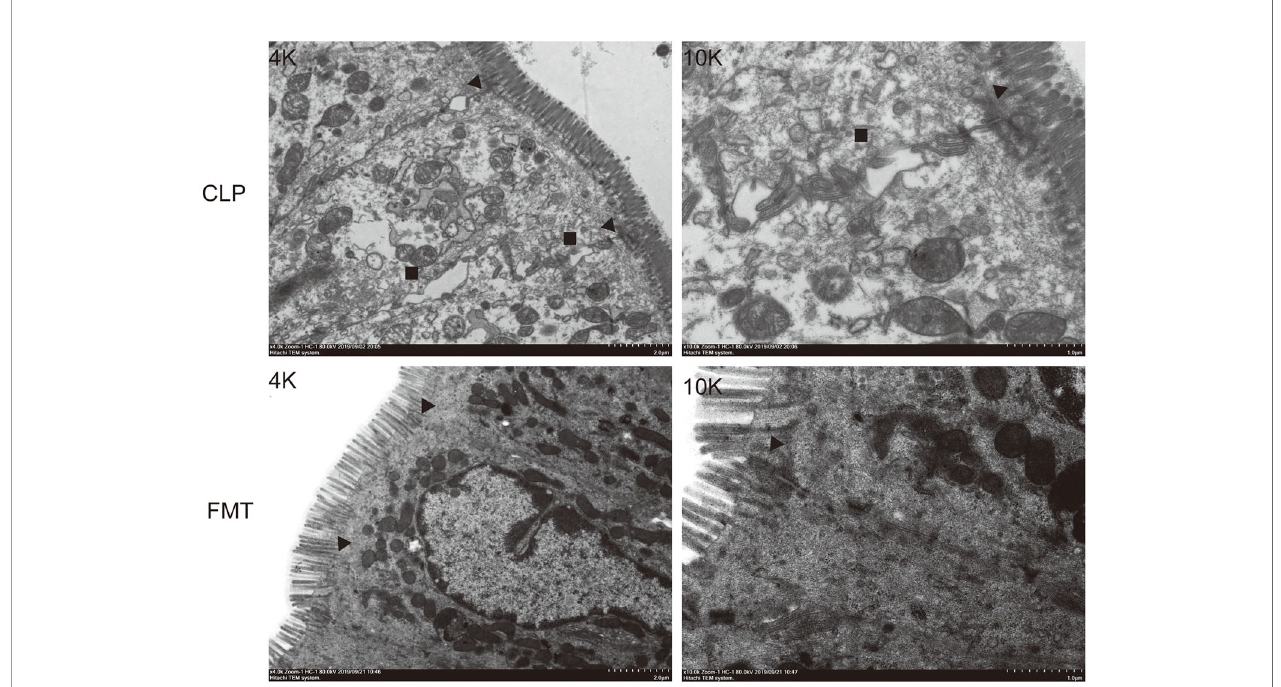
FIGURE 4 | Intestinal epithelial cell junctions. Intestinal epithelial cell junctions in the CLP group and FMT group at 48 h. The images on the left were enlarged 4K, and those on the right were enlarged 10K. ▲ Tight junction and the intermediate junction between intestinal epithelial cells. ■ The space between intestinal epithelial